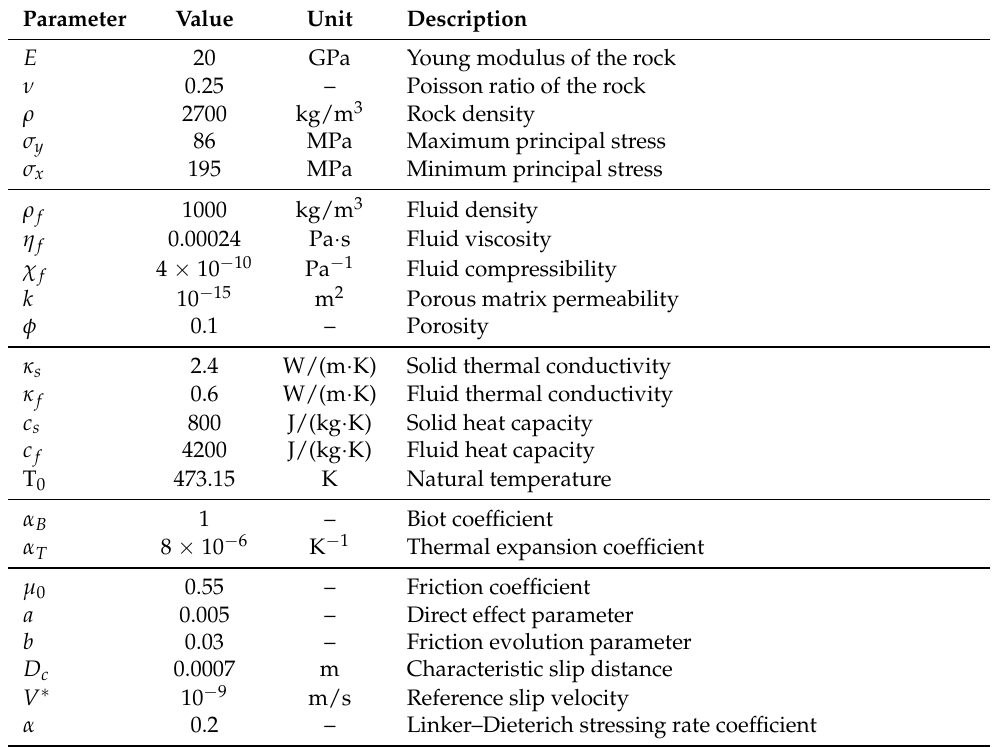
Table 1. Summary of Basel EGS reservoir model parameters, taken from